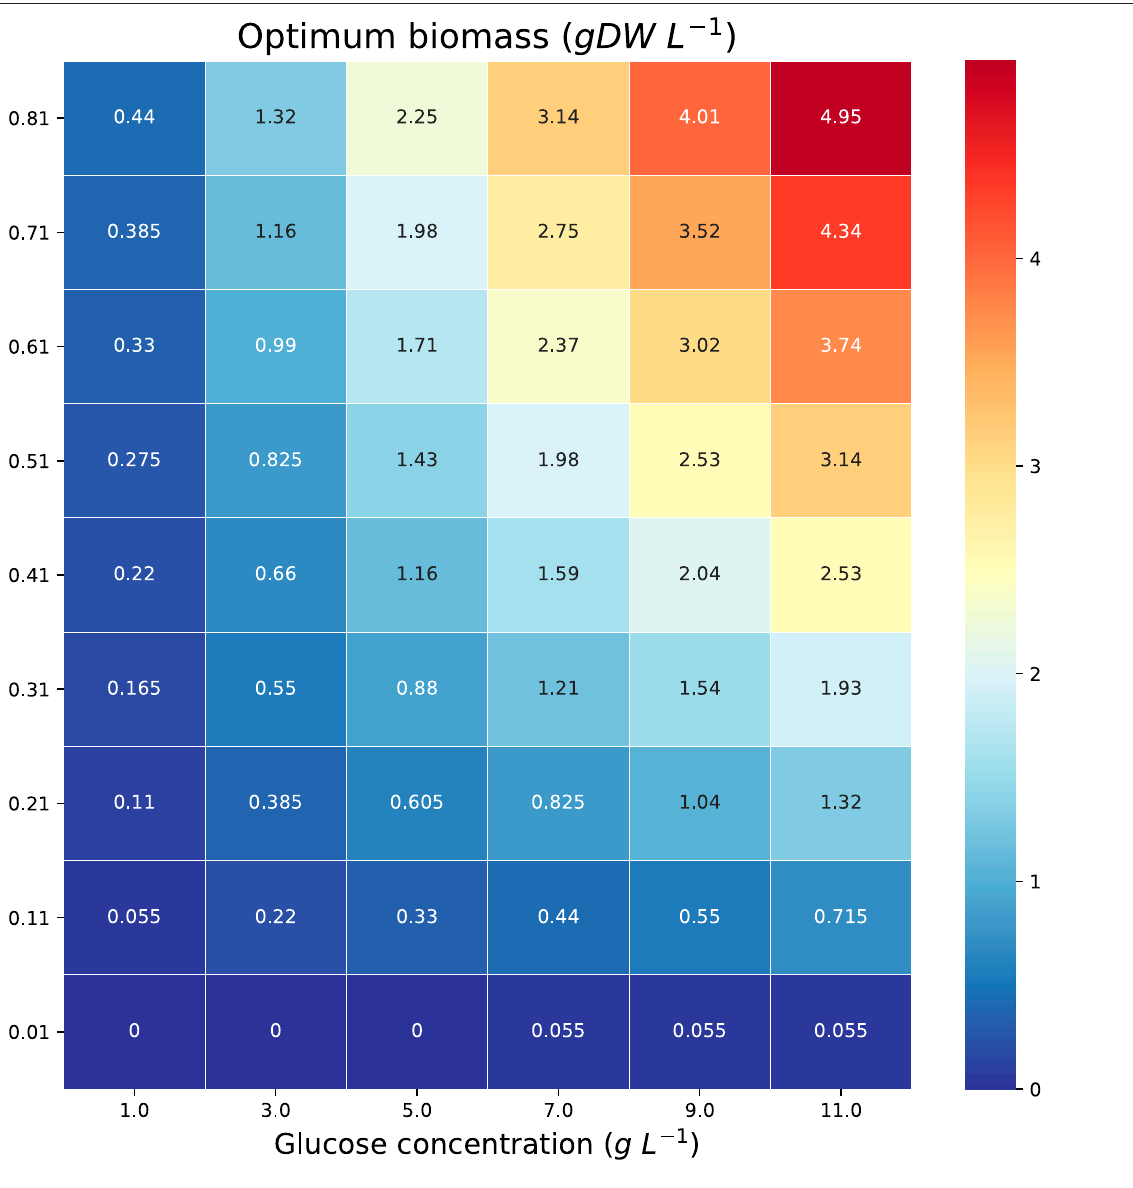
FIGURE 10 | Heatmap reporting the optimum biomass concentrations associated with each of the maximum productivities in Figures 8 , 9 .